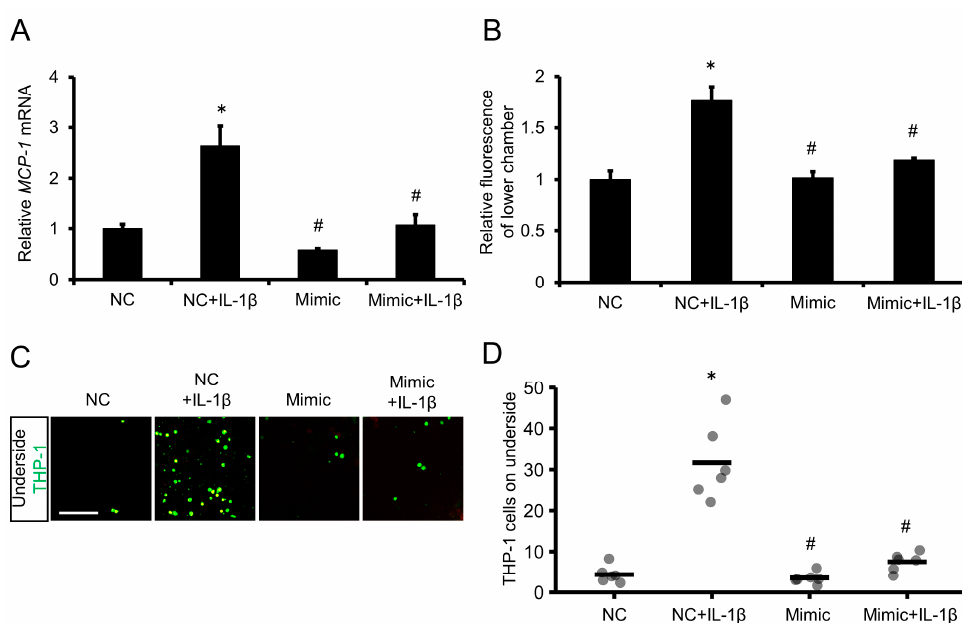
Figure 5. Transfection with miR-1914-5p mimic suppressed IL-1 β –induced transmigration of mono- cytes through an endothelial cell layer. ( A ) THP-1 cells were transfected with miR-1914-5p mimic or NC for 24 h and then incubated with IL-1 β for 24 h. MCP-1 gene expression was examined by qRT-PCR. n = 3 in each group. * p < 0.05 compared with the NC group. # p < 0.05 compared with the NC+IL-1 β group. ( B ) Monocyte transmigration through an endothelial cell layer was examined using a transmigration assay after transfection and IL-1 β exposure. Transmigration of THP-1 cells through the endothelial cell layer into the lower chamber was assessed by comparing the relative fluorescence intensity of the upper and lower chambers using a microplate reader. n = 3 in each group. * p < 0.05 compared with the NC group. # p < 0.05 compared with the NC+IL-1 β group. ( C ) Fluorescent images of the top and underside of the membrane. THP-1 cells were labeled with the fluorescent dye BCECF-AM (green). Scale bar represents 100 µ m. ( D ) The number of fluorescent THP-1 monocytes on the underside of the membrane was determined. n = 6 fields in each group. * p < 0.05 compared with the NC group. # p < 0.05 compared with the NC+IL-1 β group.